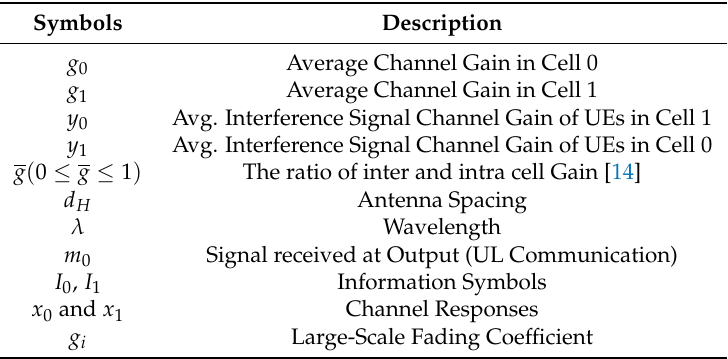
Figure 3. A Two Cell Scenario: Channel gain between every UE and BS is identical in each cell. Table 1. Description of different